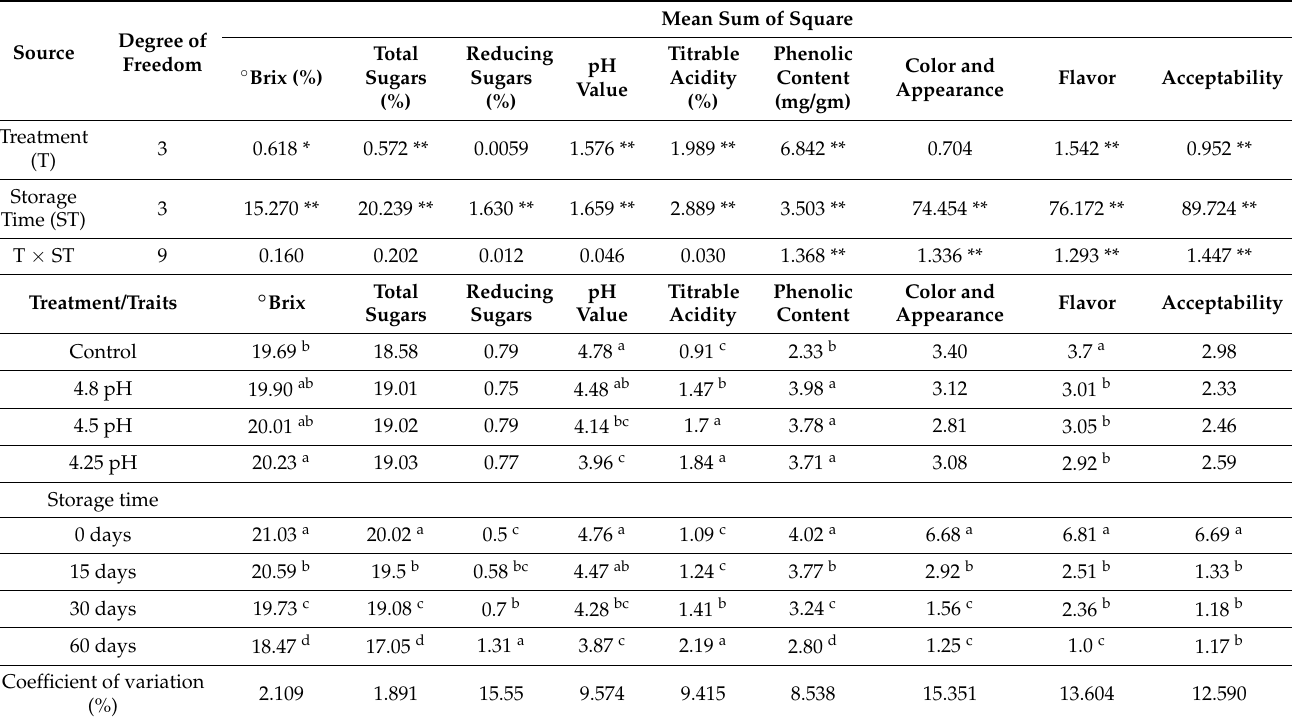
Table 3. Two-way ANOVA showing the effect of acidification on the physico-chemical properties and sensory evaluation at different storage intervals of sugarcane